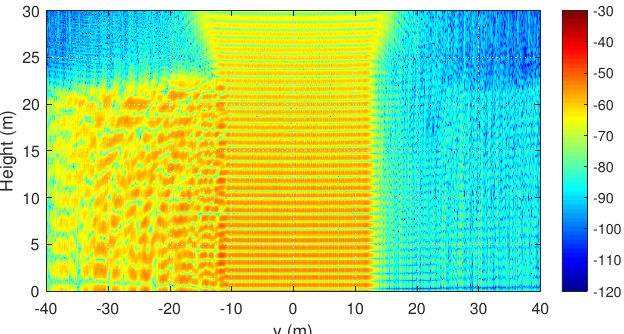
Figure 11. Propagation in a crossroad. Two-dimensional distribution of the signal level (dBm) at the distance of 125 m from the source along a perpendicular street, obtained by the two-way PE